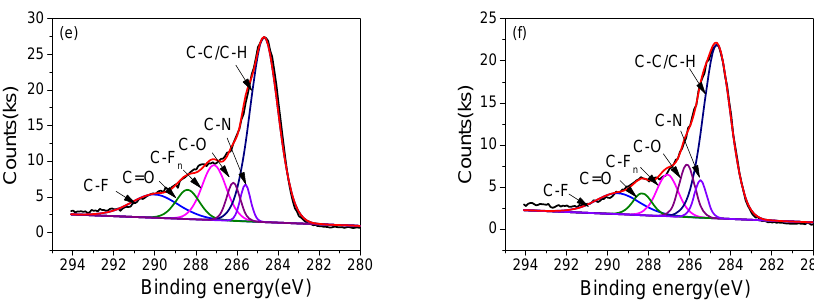
Figure 13. High resolution XPS spectra of C1s peak of ( a ) unaged and ( b ) 10 h aged un ‐ fluorinated PI; ( c ) unaged and ( d ) 10 h aged 30 min fluorinated PI; ( e ) unaged and ( f ) 10 h aged 60 min fluorinated PI.